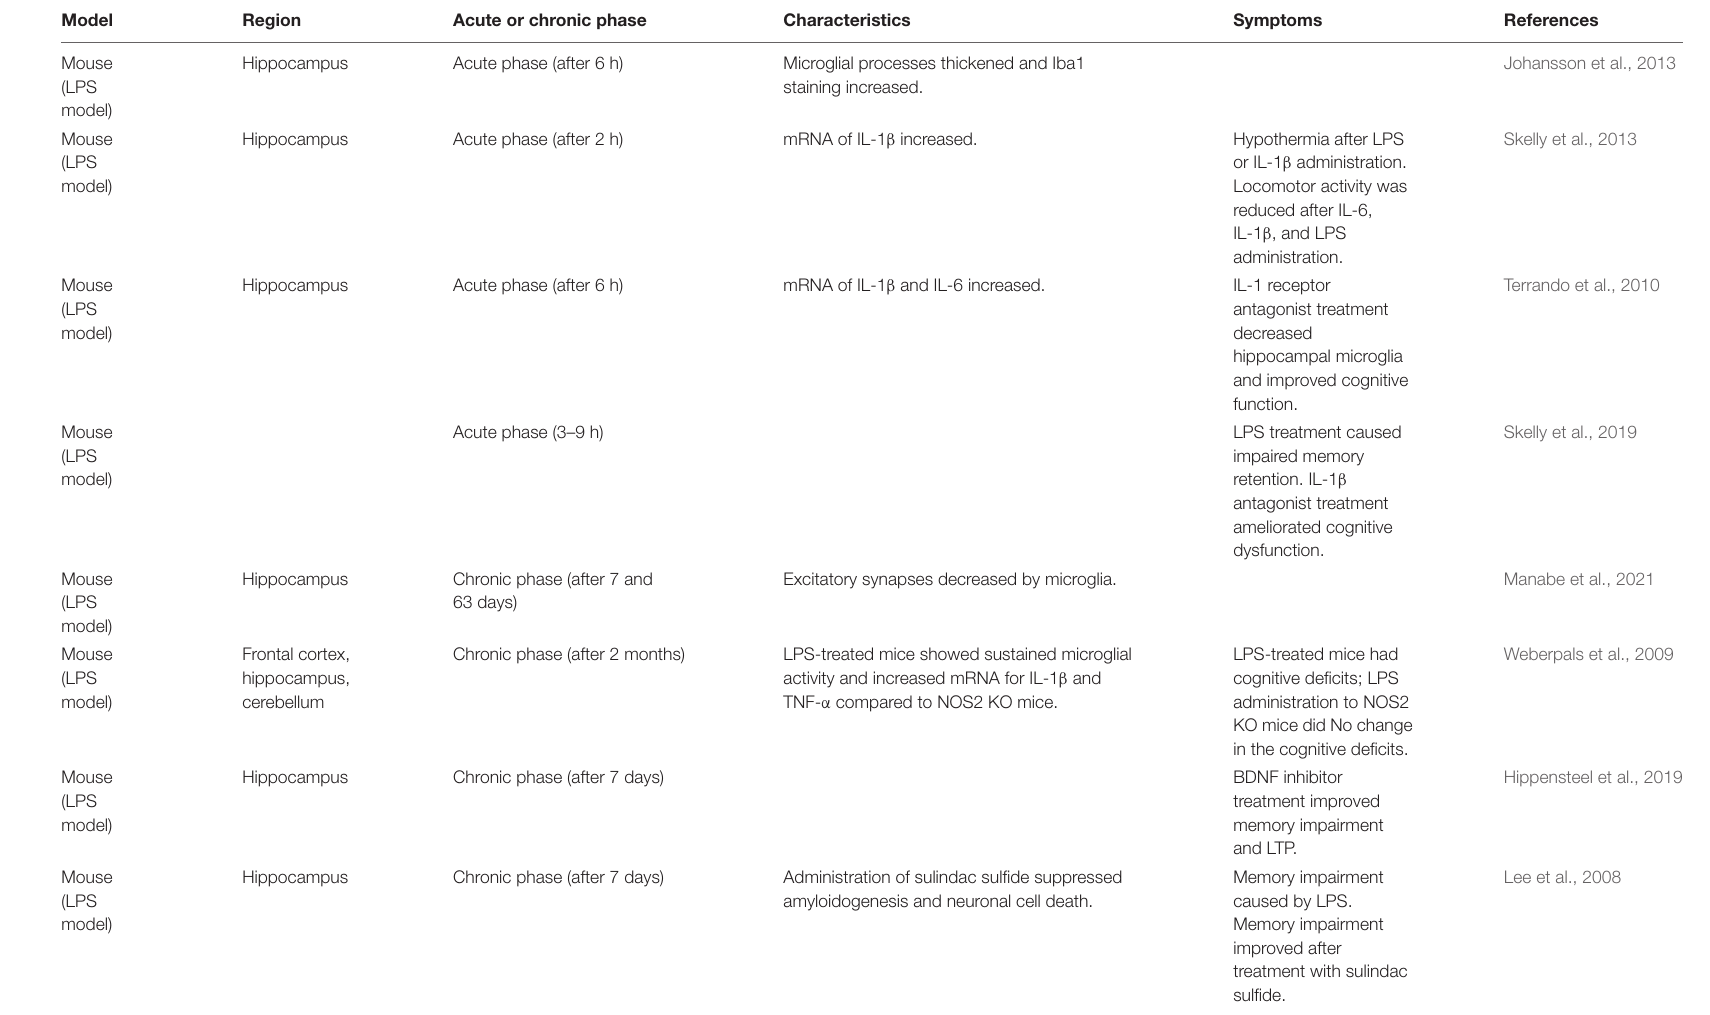
TABLE 2 | Brain dysfunction in mouse and rat sepsis